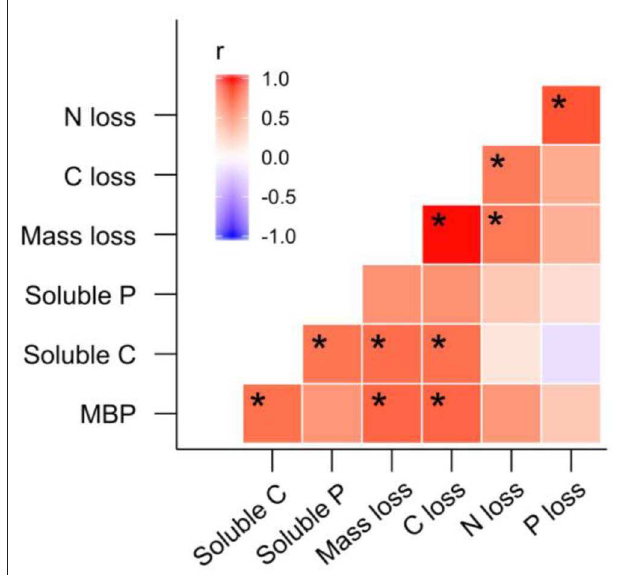
FIGURE 9 | Matrix of Pearson’s correlation coefficients for correlations among litter microbial biomass phosphorus (MBP), litter soluble carbon (C), litter soluble phosphorus (P), litter mass loss, C loss, N loss, and P loss; significant correlations are denoted “*”.